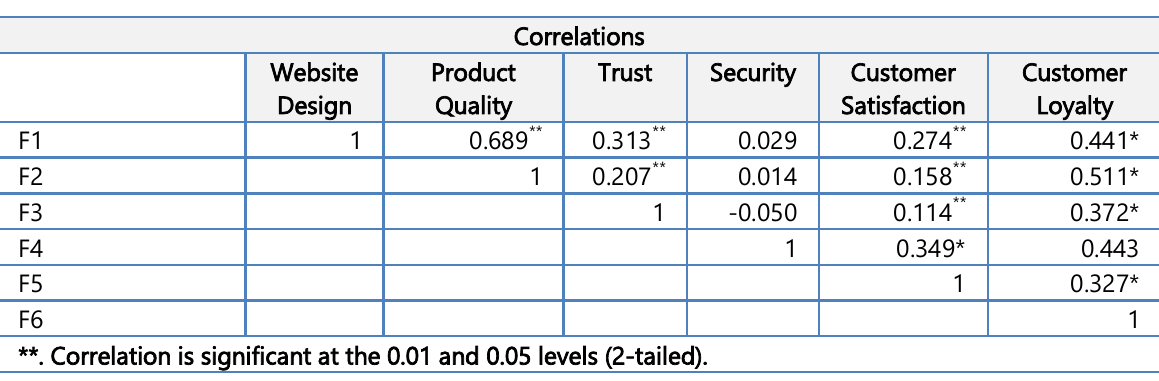
Table 4: Association between the Factors That Influencing Digital Marketing and the Customer Loyalty (Source: Authors‟